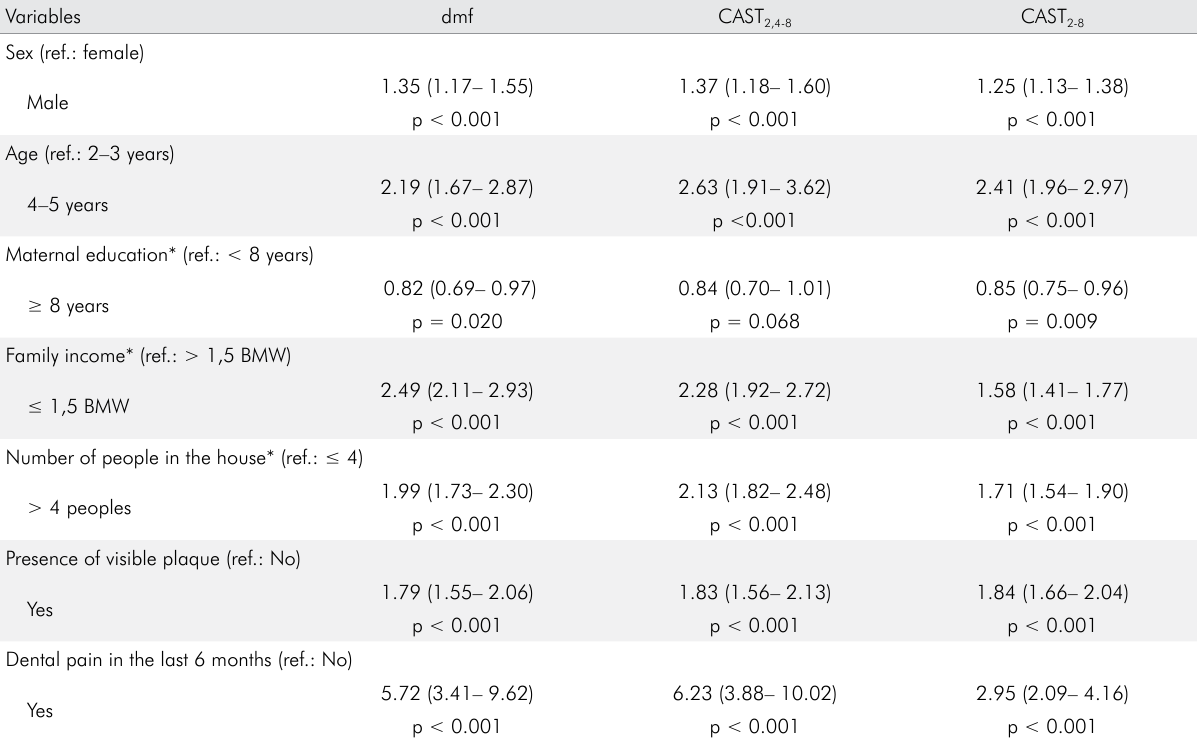
Table 4. Rate ratio values (95%CI) calculated by Poisson regression using experience values as the outcome according to the CAST at thresholds CAST and CAST and to the dmf index and independent variables (n = 2,4– 8 2– 8